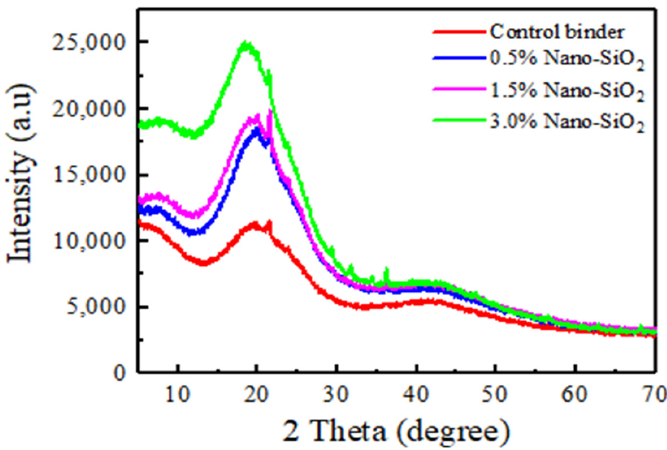
Figure 5. XRD patterns of terminal blend rubberized asphalt with and without nano silica particles.